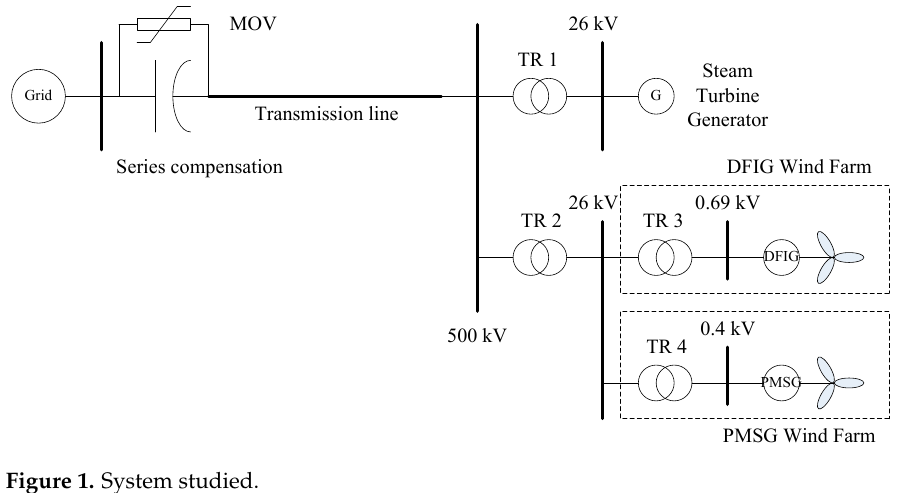
Figure 1. System